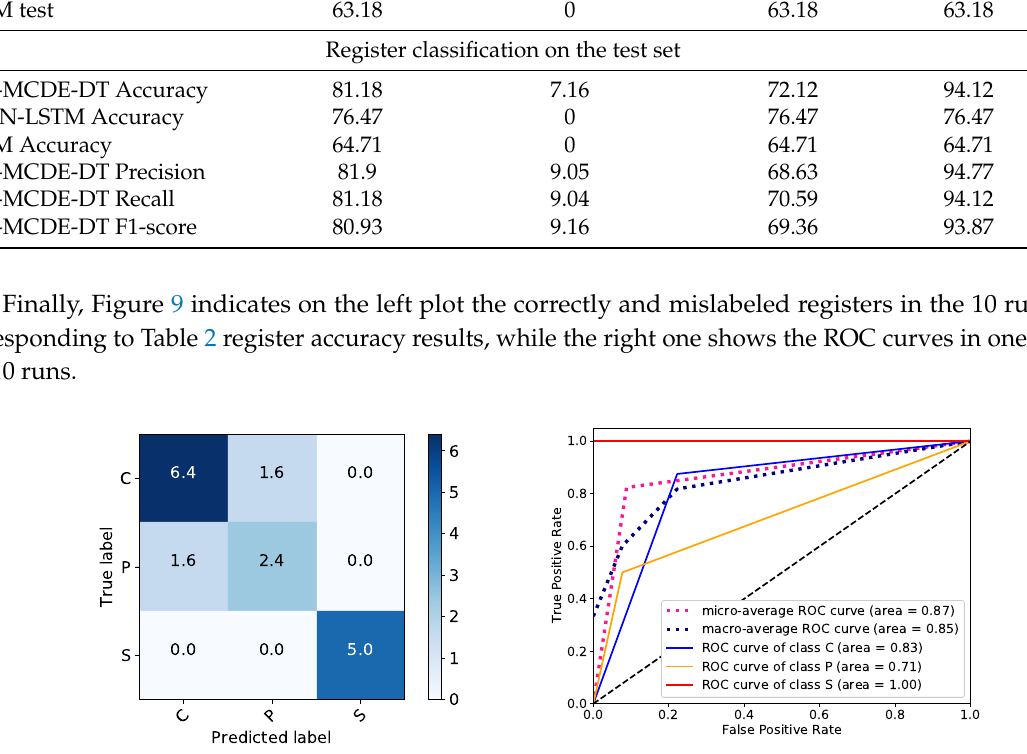
Figure 9. Confusion matrix of test registers obtained after 10 repeated runs of the DL-MCDE-DT model ( left ) and ROC curves for one run (accuracy 82.35%) ( right